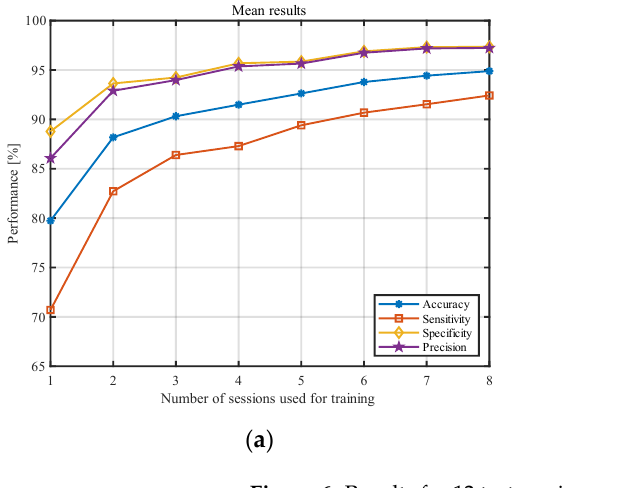
Figure 6. Results for 12 test sessions and the training ones varying from one to eight. ( a ) Classification measures. ( b ) Standard deviations averaged over all individuals. Table 5. Classification measures averaged over all participants obtained for the number of training sessions varying from 1 to 8 and the 12 testing sessions.